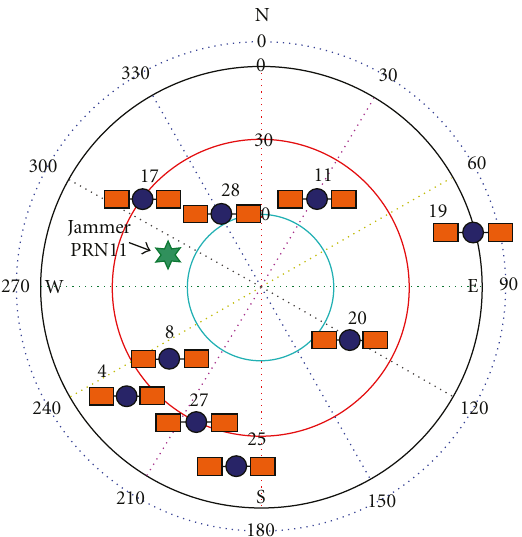
Figure 8: Sky plot of GPS satellites and near-field pseudolite